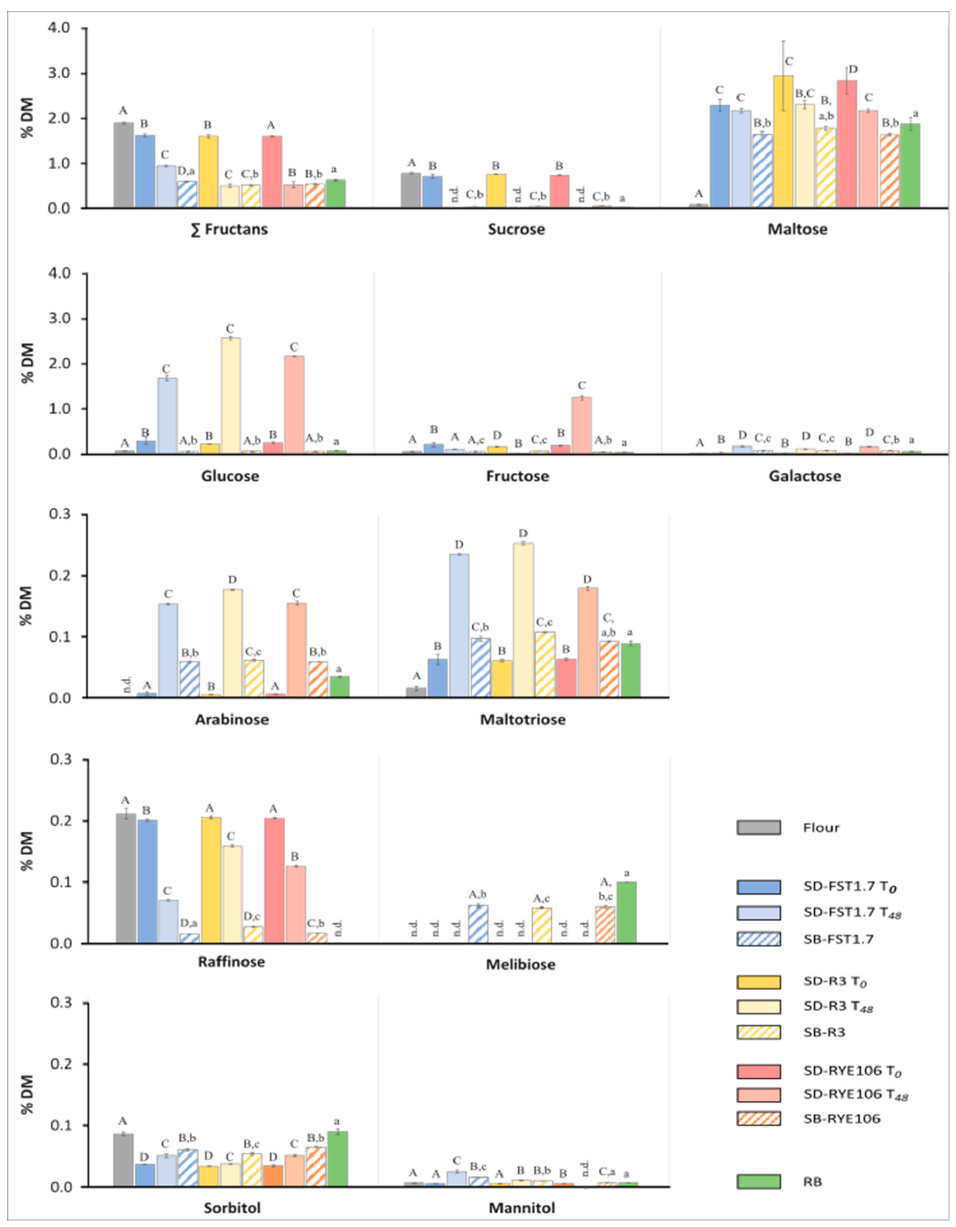
Figure 4. Carbohydrate profile of whole-wheat flour (grey bars), sourdoughs inoculated with Lacti- plantibacillus plantarum FST1.7 (blue bars), Lacticaseibacillus paracasei R3 (yellow bars), and Pediococcus pentosaceus RYE106 (red bars) directly after mixing (SD T0—dark bars), after 48 h of fermentation at 30 °C (SD T 48 —light bars), in breads with 20% sourdough and 2% yeast (SB—dashed bars) and ref- erence bread (RB, green bar) produced with commercial baker’s yeast preparation (2%; Puratos, Belgium). Carbohydrate concentrations are expressed as a percentage of dry ma tt er (%DM); n.d.— not detected or levels below 0.005% DM. Di ff erent capital le tt ers above columns represent signi fi - cant di ff erences in the concentration of individual carbohydrates between fl our, T 0 , T 48 , and SB of selected species; di ff erent lower-case le tt ers represent signi fi cant di ff erence in individual carbohy- drate content between the di ff erent SBs and RB ( p < 0.05).